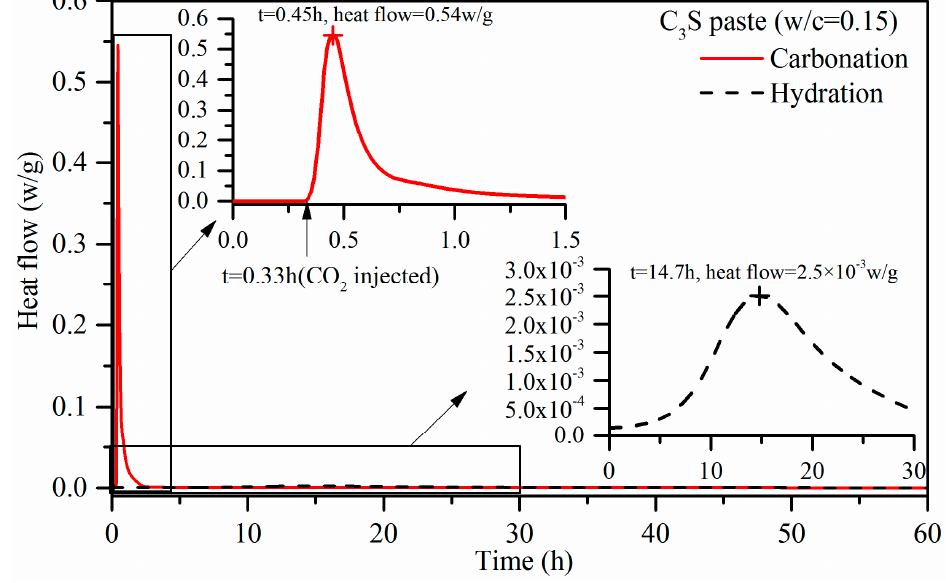
Figure 5. Heat flow of carbonation and hydration versus time.